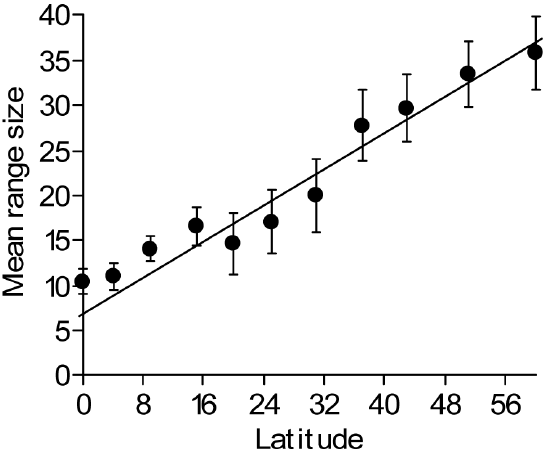
Figure 2. Relationships between latitude (x-axis, in °S) and mean range size for Sciuridae genera in the Southern hemisphere (y- axis, in number of cells). Statistics of the regression: r = 0.967, mean range = 0.409 latitude + 10.25. Error bars are given for each data